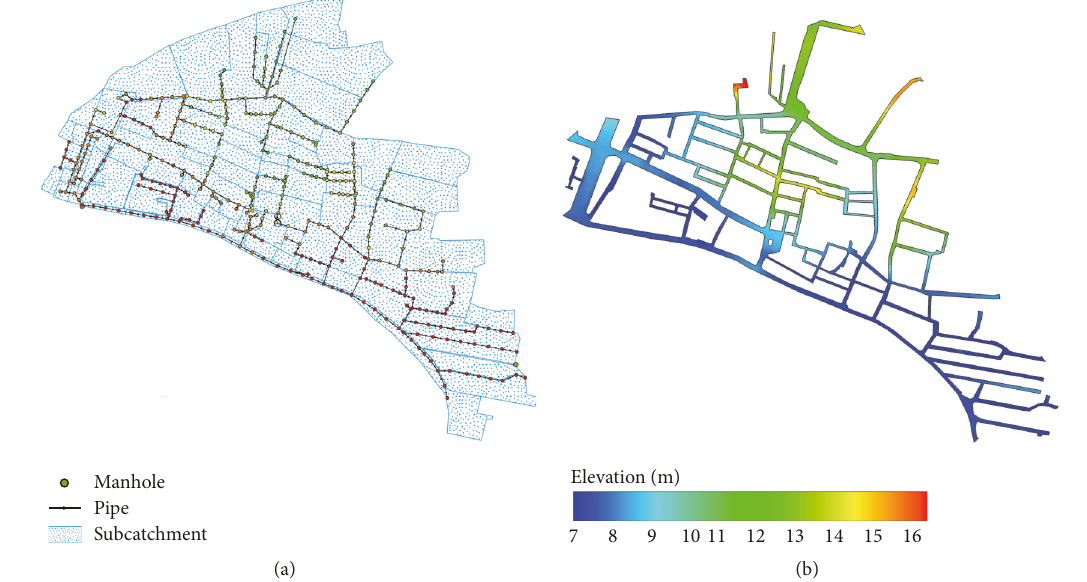
Figure 12: Schematic illustration and computational domain: (a) subcatchments and conduits; (b)